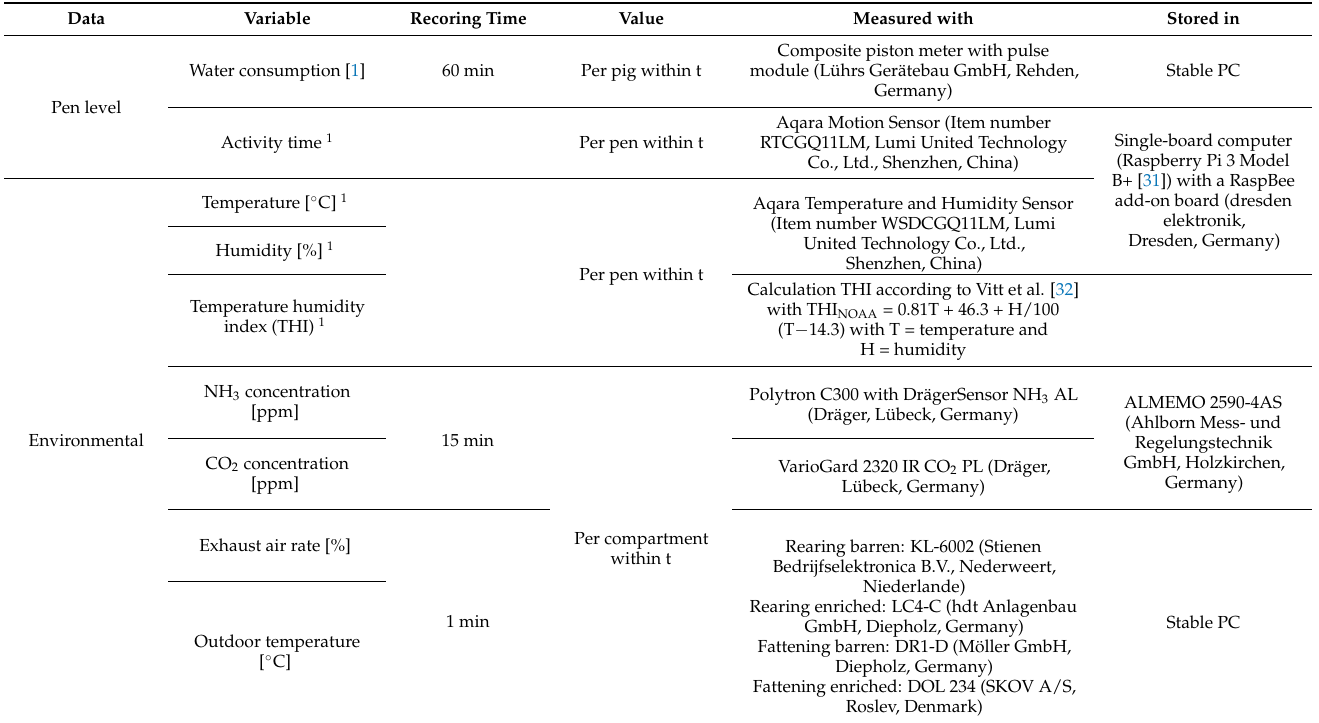
Table 2. Pen-level and environmental variables were direct observations or sensor data. Sensor data variables according to recording time, the value used in the model and the information relating to how the variables were measured or stored. Within t (period between two tail lesions scoring days), the data were aggregated and allocated to the following tail lesions scoring day. Mean and coefficient of variation (CV) were selected as features for the sensor data